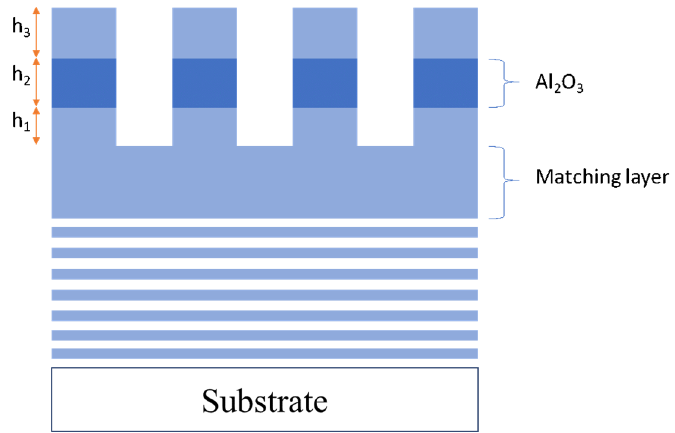
Figure 6. Schematic of three−layer MDG.